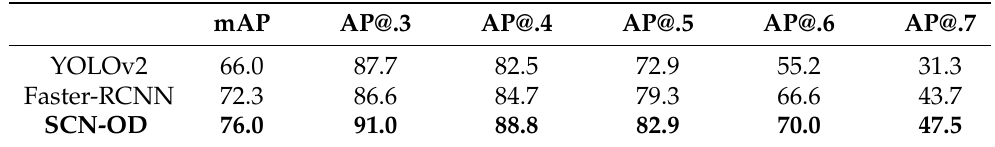
Table 1. Results for individual tree detection, measured by the average precision (AP) for different intersection of union thresholds in %. mAP